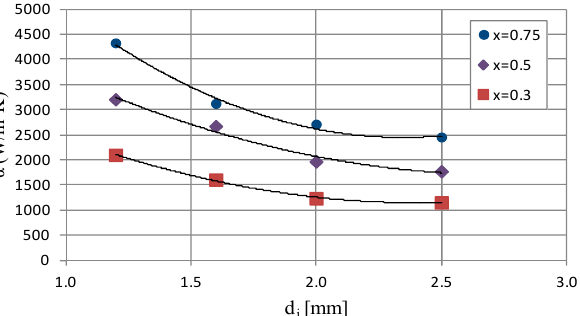
Figure 7. Dependence of heat transfer coefficient on internal diameter of minichannel α = f(d i ) for G ≈ 519 kg/m 2 s, inlet T s = 39 °C.